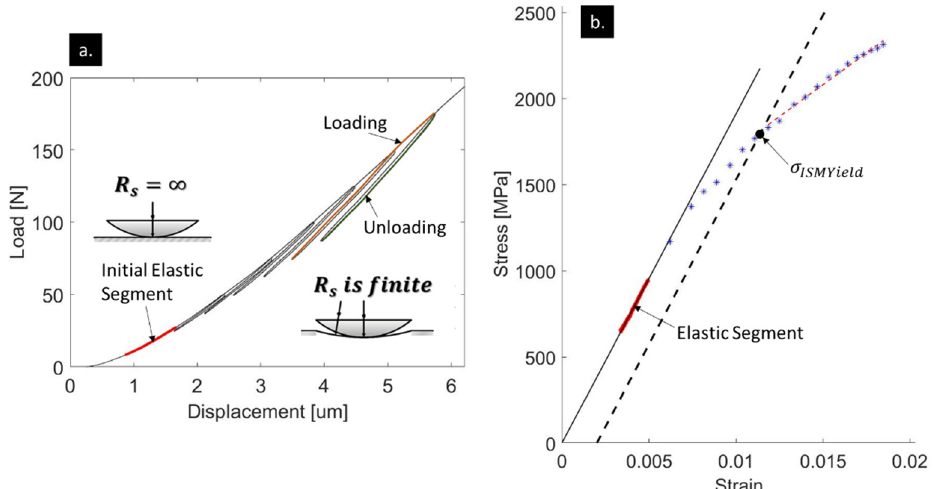
Figure 3. ( a ) A typical measured load-displacement response in the indentation protocols used in this work. The initial elastic response shown is analyzed using Hertz’s theory. ( b ) The corresponding indentation stress-strain curve extracted from ( a ).